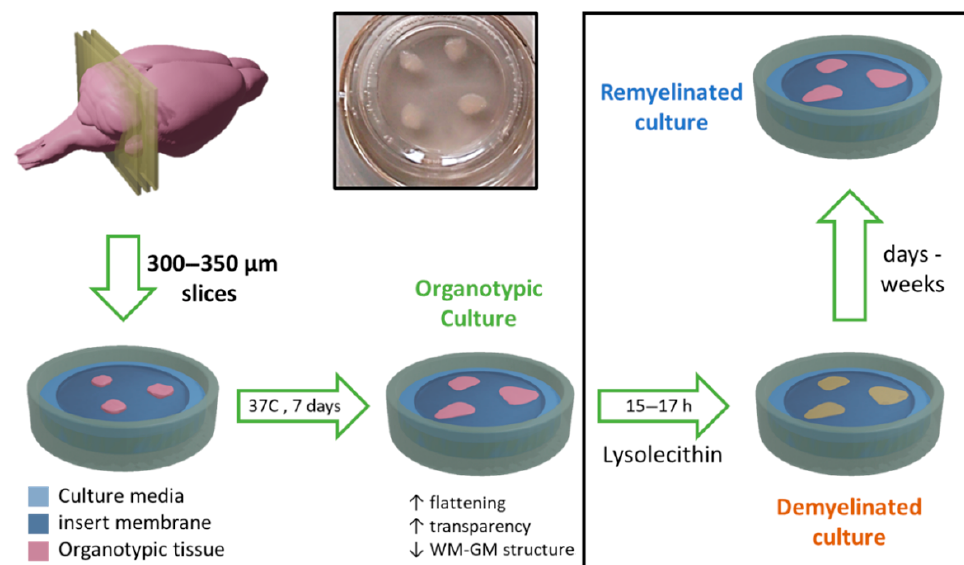
Figure 1. Preparation of cerebellar organotypic brain cultures from tissue sections. Postnatal (7–12 days) mouse brains were extracted and sliced into 300–350 µm sections. Slices were cultured for one week on a permeable membrane in contact with the medium. Optionally, lysolecithin may be used to induce demyelination. Remyelination may take place spontaneously or may be promoted by therapeutic intervention. (WM: white matter, GM: gray matter).